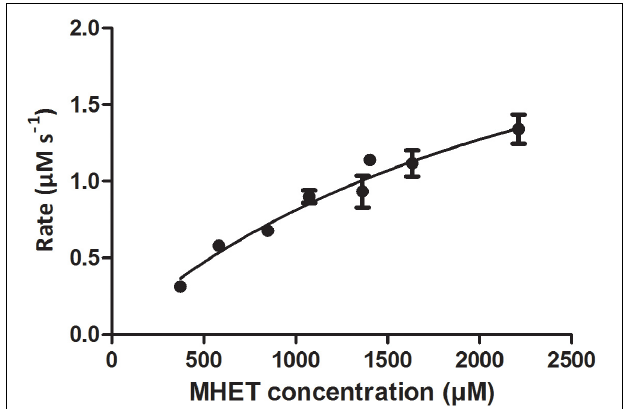
FIGURE 3 | Rate of MHET catalysis by Mle046 plotted against substrate concentration. Degradation rates are expressed in terms of µ M MHET degraded per second. Error bars indicate standard deviation ( n = 3).